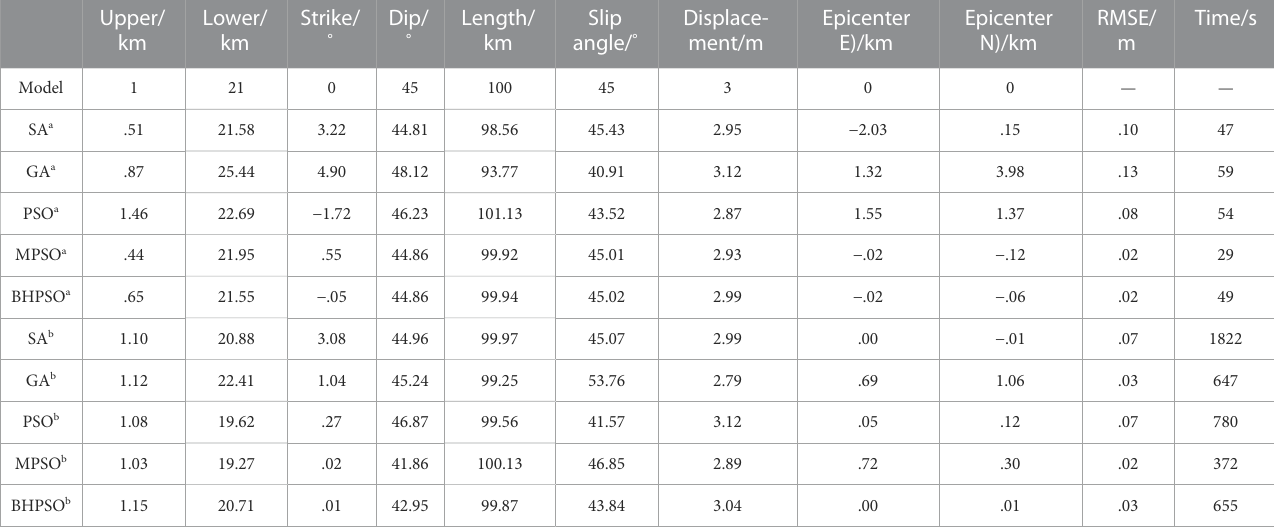
a Represent the GPS, data. b Represent the InSAR,